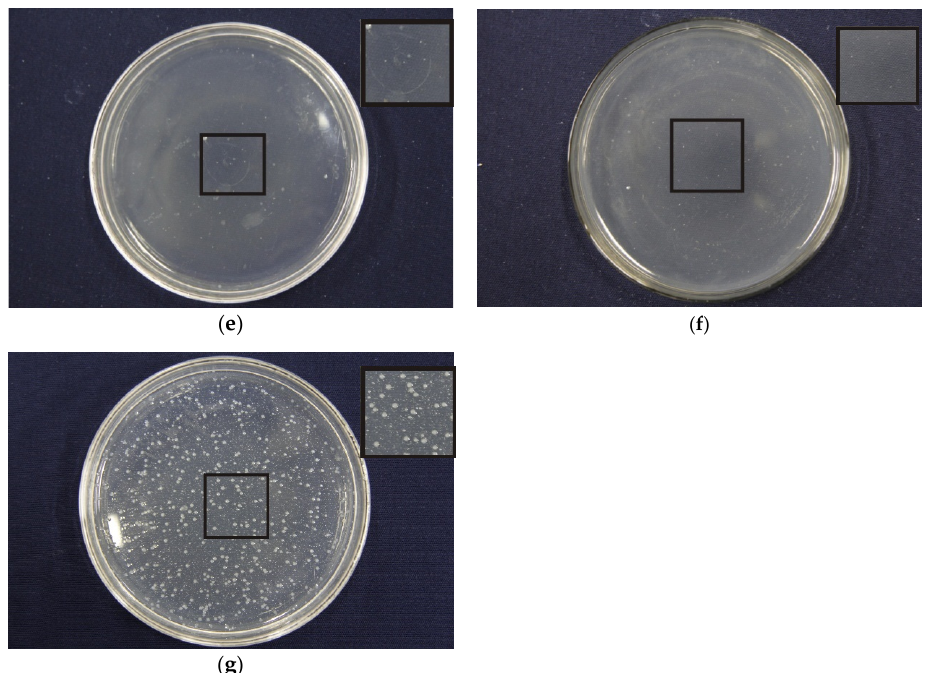
Figure 7. Effects of different composite ratio on antibacterial properties of PLA/PEG/Cur nanofibers membranes: ( a ) PEG:PLA = 1:7 (0% Cur); ( b ) PEG:PLA = 1:1 (3% Cur); ( c ) PEG:PLA = 1:3 (3% Cur); ( d ) PEG:PLA = 1:5 (3% Cur); ( e ) PEG:PLA = 1:7 (3% Cur); ( f ) PEG/PLA = 1:9 (3% Cur); ( g ) cotton. Table 5. Effects of different composite ratio on antibacterial properties of PLA/PEG/Cur nanofiber membranes.